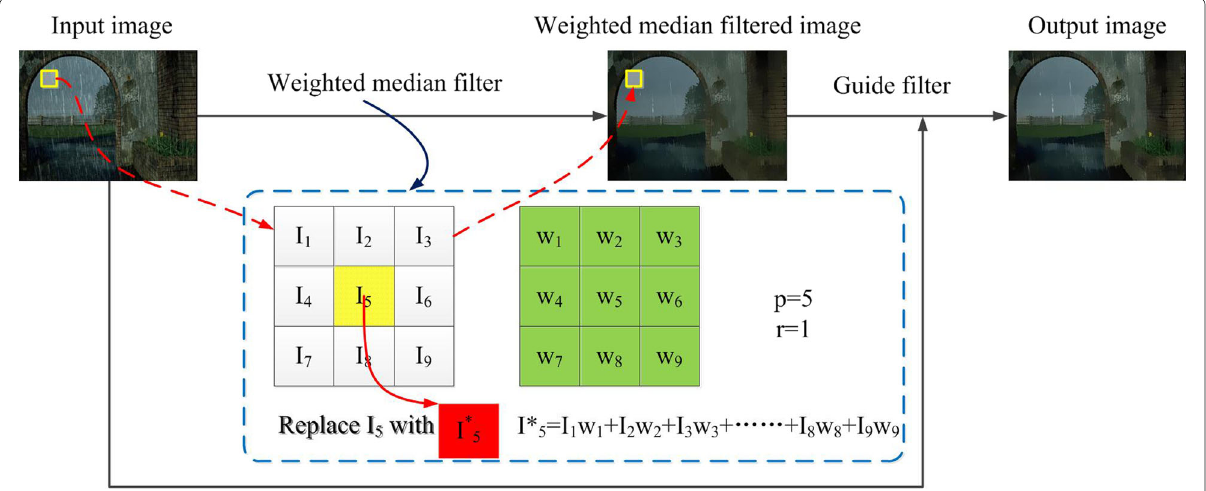
Fig. 1 Framework of the proposed method. It consists of two computation stages: firstly, to filter the input rainy image using the weighted median filter; then, the weighted median filtered image is used as a guide image and convoluted with the input rainy image to get the final rain-free